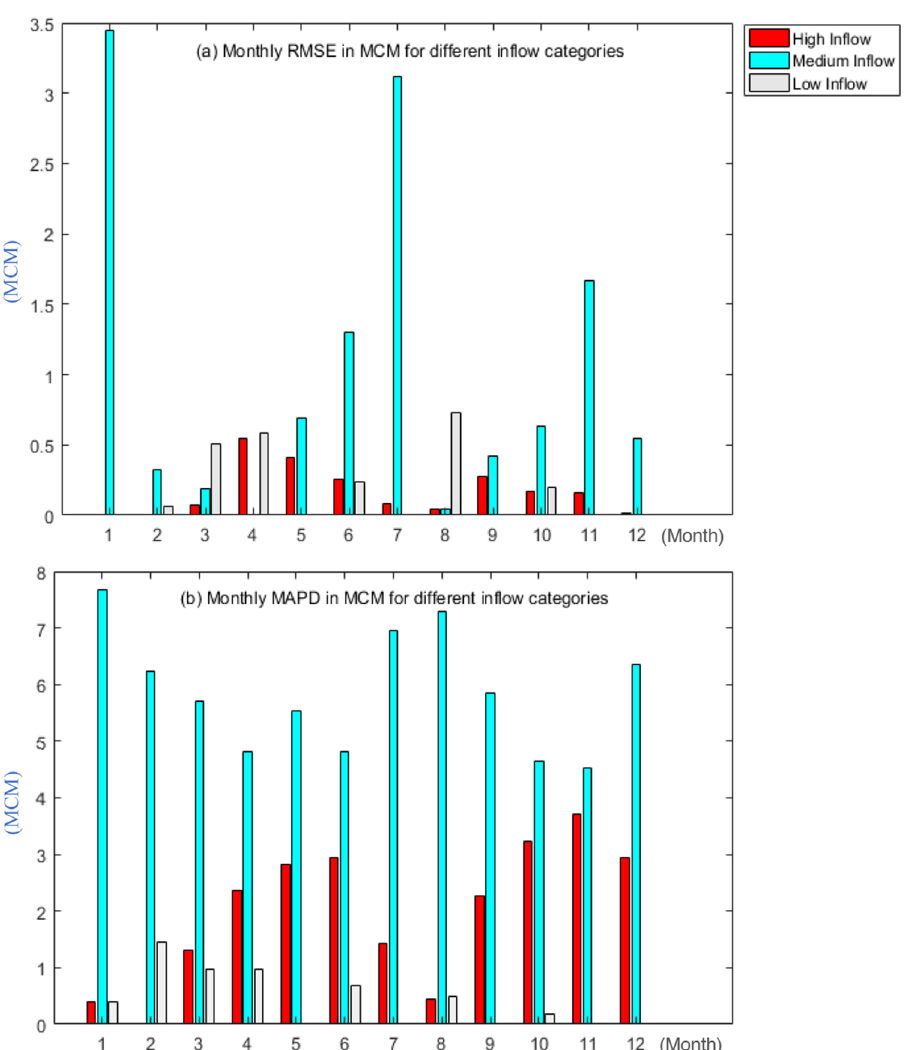
Figure 4. ( a ) and ( b ) Monthly RMSE and MAPD in MCM in different inflow